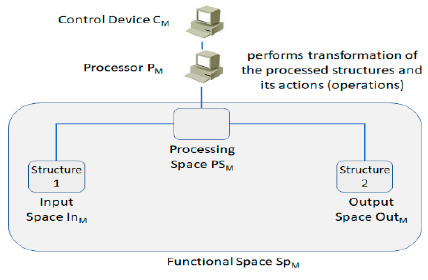
Figure 3. Structural machine framework for information processing structures.